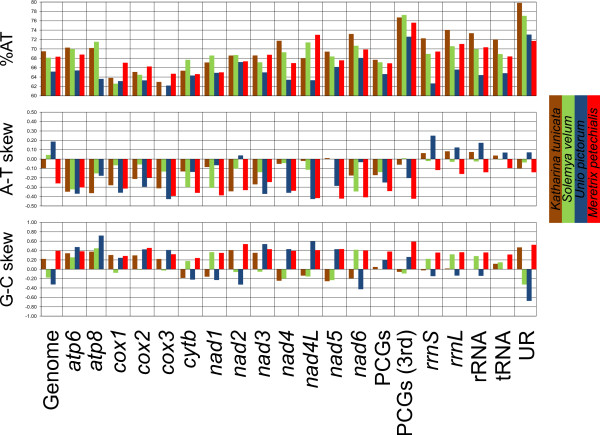
Compositional patterns of S. velum and other mollusks mitochondrial genomes. A-T content, A-T skew, and G-C skew are computed for each single gene and for many genomic regions following the legend below the chart.